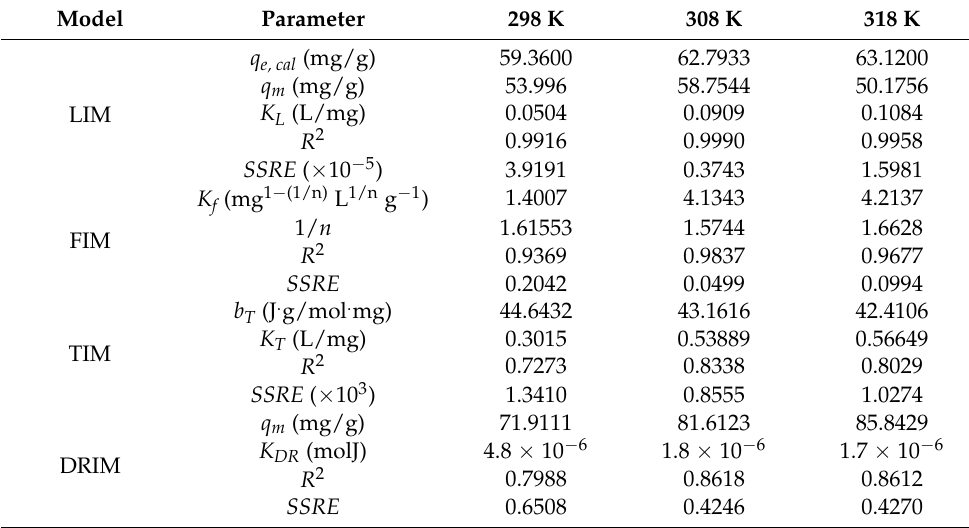
Table 1. Comparison of LIM, FIM, TIM and DRIM isotherm parameters obtained for CAPC-CFS